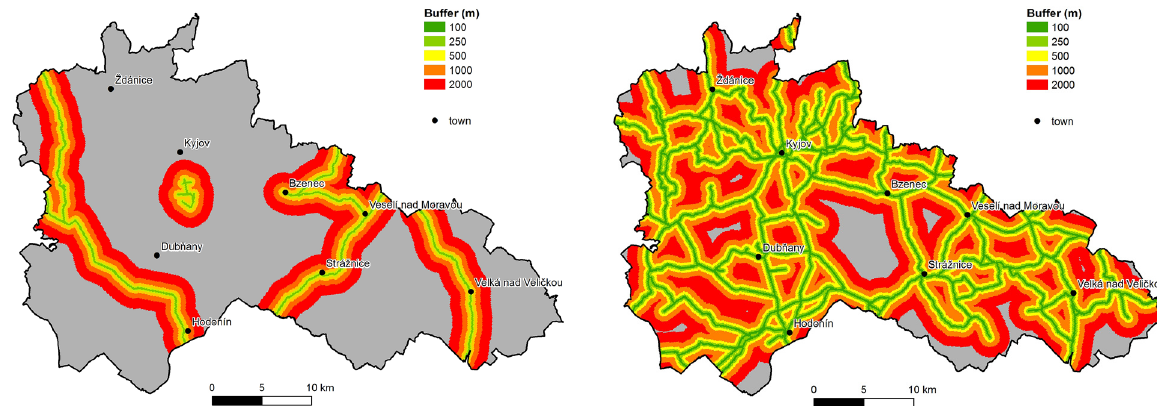
Fig. 4. The road network in the Hodonín region in the 1840s (left) and 2010s (right) with distance zones from a road